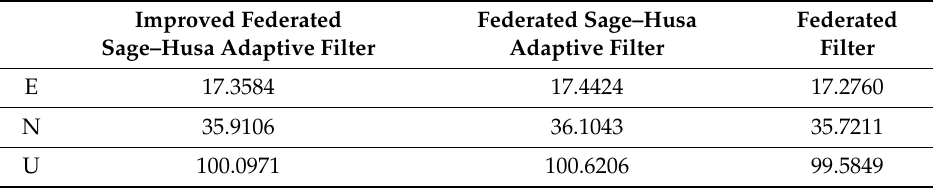
Table 1. Position error (m).